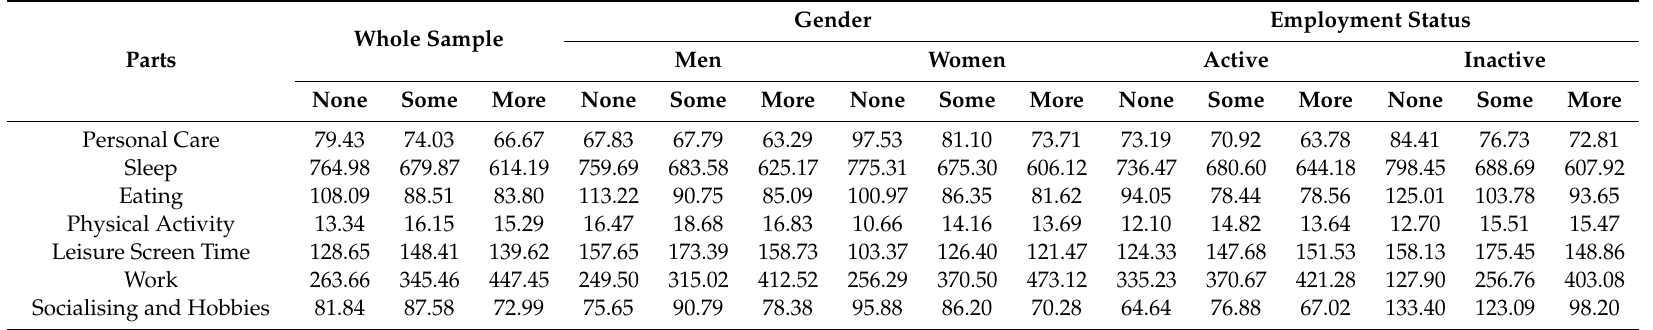
Table A2. Model-adjusted compositional means (mins / day) by foodwork category for whole sample and population subgroups.